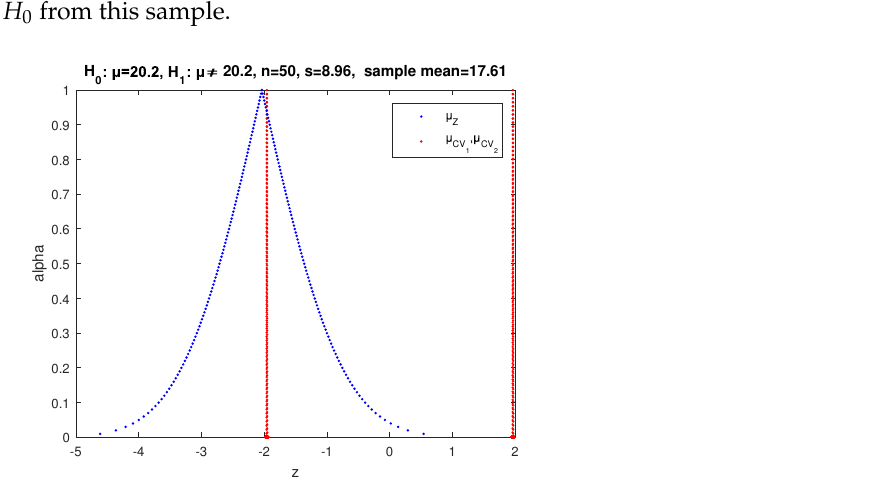
Figure 4. The possibility distribution of the fuzzy statistic Z for the test of Example 1 from a sample with x 1 = 17.6.